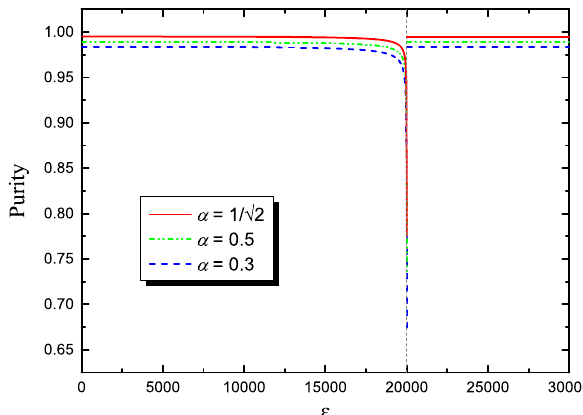
Fig. 1 The purity Tr (ρ 2 ) of the final state of the qubit as a function of the volume ε of the cosmic expansion. The expansion rapidity is σ = 5. The qubit energy level difference is (cid:15) = 2, the inner product of the mode functions, defined in Eq. (21), is μ = 0 . 1, the mass of the scalar field particle is m = 0 . 01. The initial state of the qubit is α | 0 (cid:7) + β | 1 (cid:7)